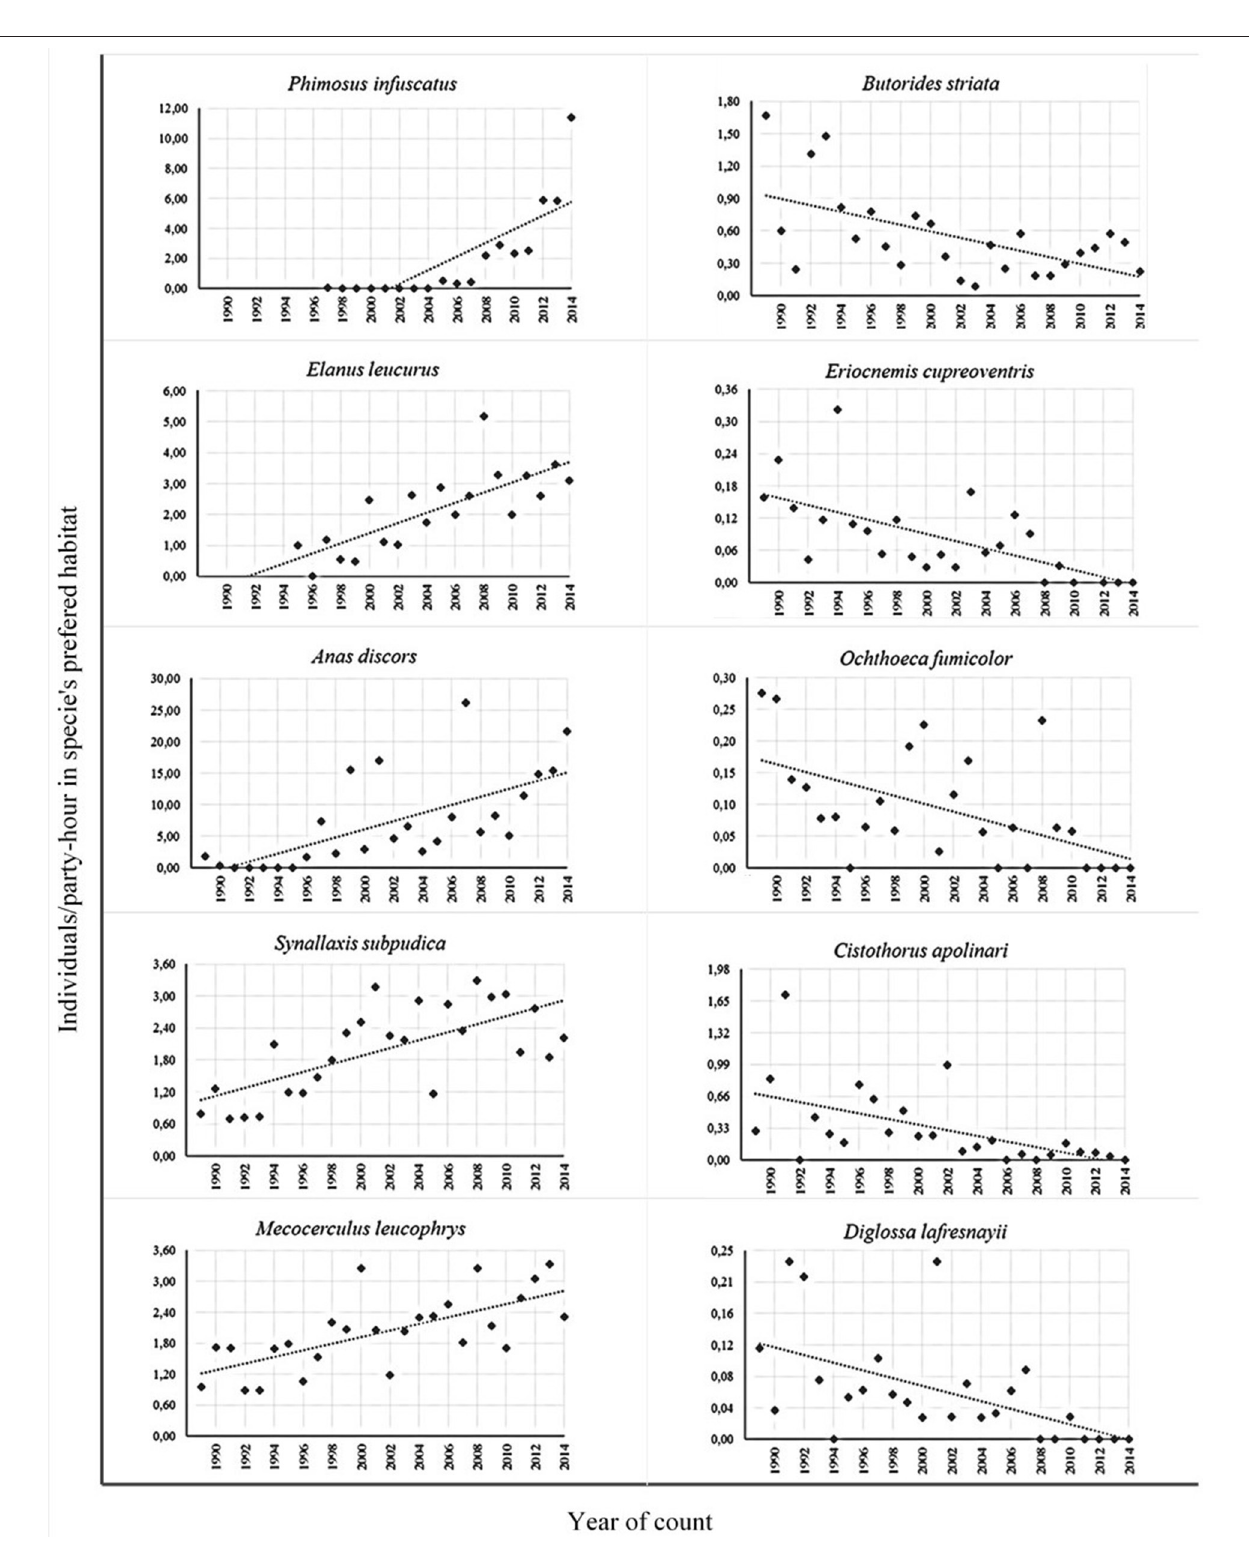
FIGURE 7 | Examples of bird species that increased or decreased significantly between 1989 and 2014 in the Sabana de Bogotá Audubon’s Christmas Bird Count circle.